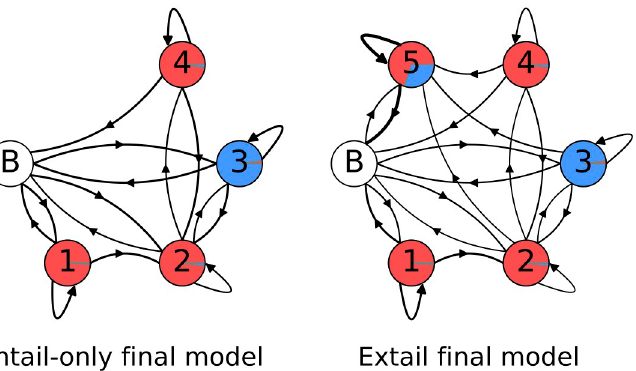
Fig 14. Final model topologies. Pre-training model topologies and emissions for the best unstructured models for each tail dataset. The areas covered by the separate colors in each state circle are proportional to their emissions: uncolored circle labeled ‘B’ indicates the beginning/end state, red is a single adenine addition, and blue is a single uracil addition.